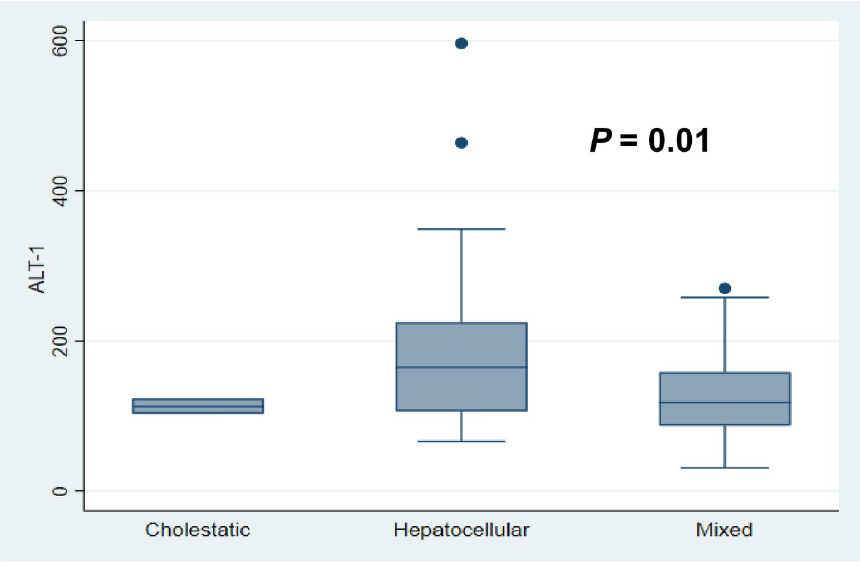
Fig 3. Serum alanine aminotransferase (ALT) and the different biochemical phenotypes of DILI.